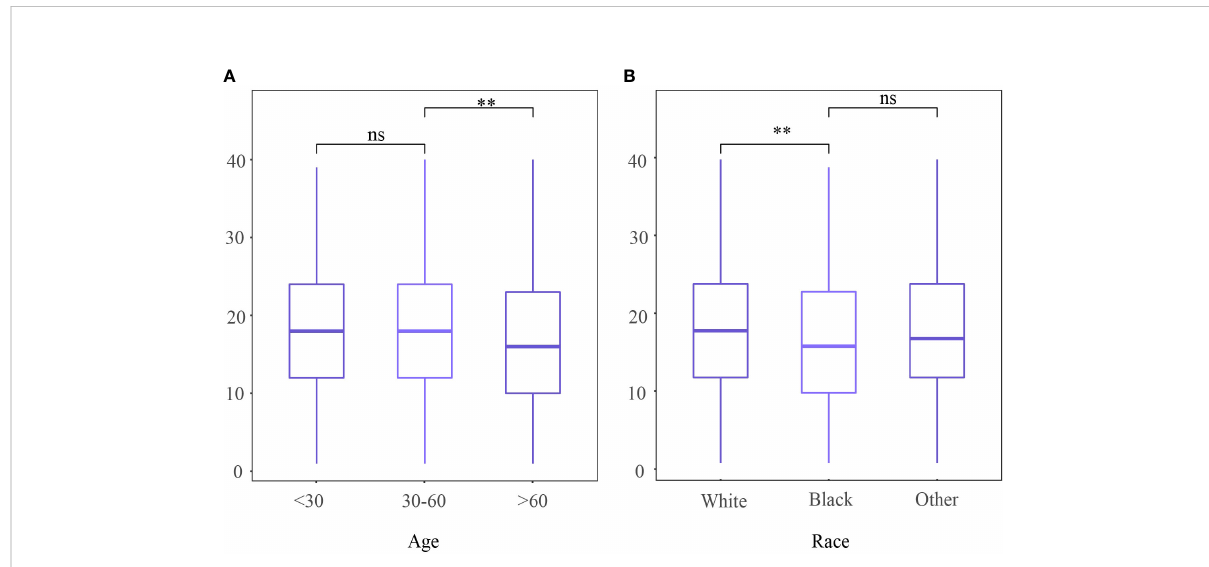
FIGURE 2 Number of examined lymph nodes among different (A) age and (B) race. ns,no signi fi cant difference; ** P <